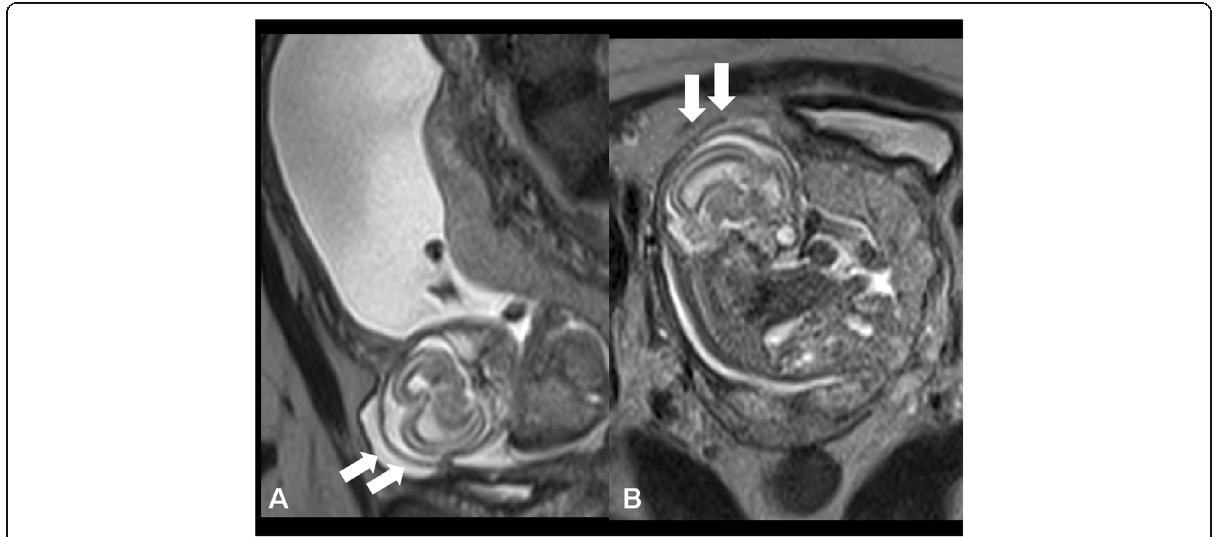
Fig. 5 a Sagittal T2 W. b Axial T2W images show myometrial thinning with focal bulge in the right lateral aspect of the anterior wall of the uterus (arrows), in the region of the previous cesarean scar suggesting uterine dehiscence